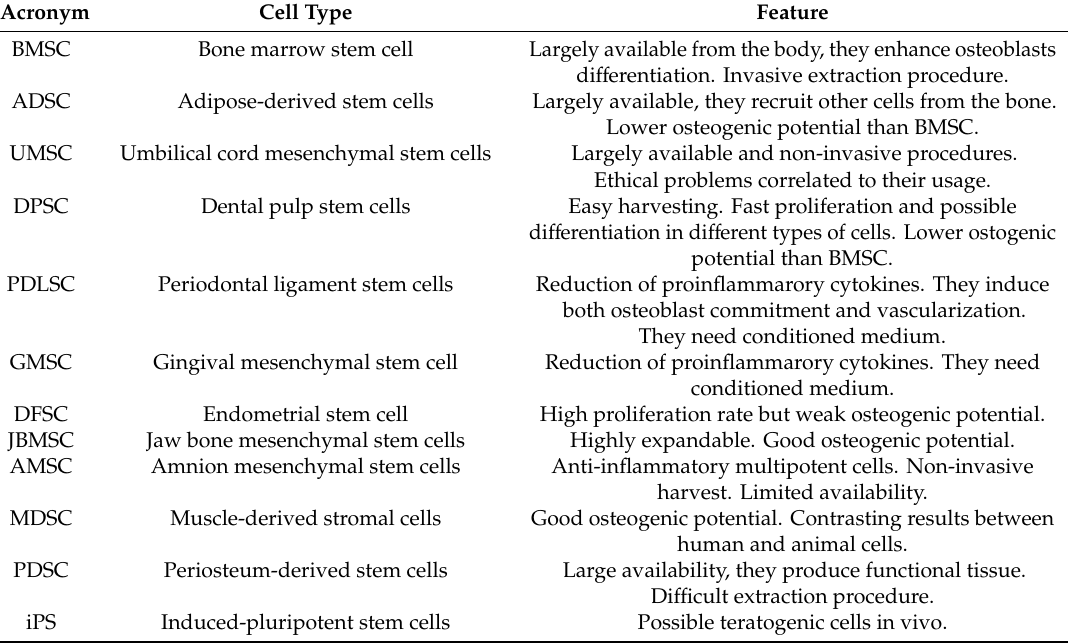
Table 2. List of stem cell types for bone tissue regeneration and their